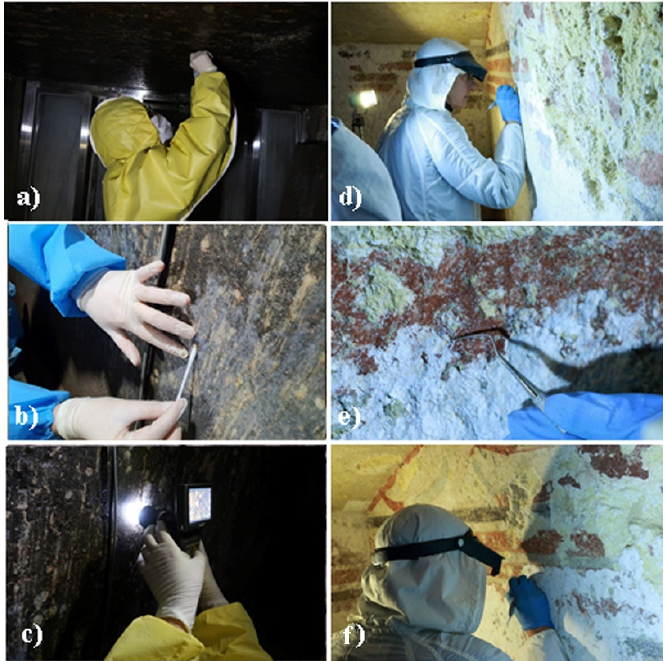
Figure 6. Restoration activities carried out in Korean ( a – c ) and Italian sites ( d – f ) respectively. ( d – f Courtesy of Amici delle Tombe di